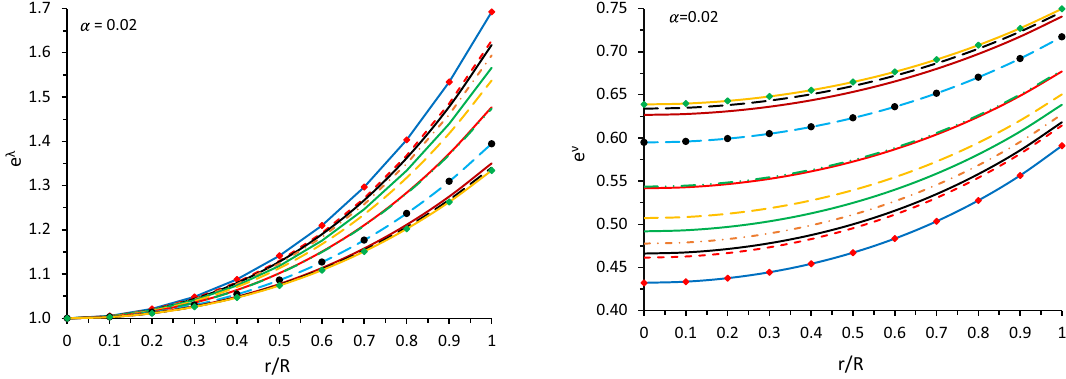
Fig. 4 The behavior of gravitational potentials e λ( r ) (left panel) and e ν( r ) (right panel) versus radial coordinate r / R by taking the numerical values of the constants a = 0 . 003, b = 0 . 0000053, β = 1 . 1, and γ = − 0 .